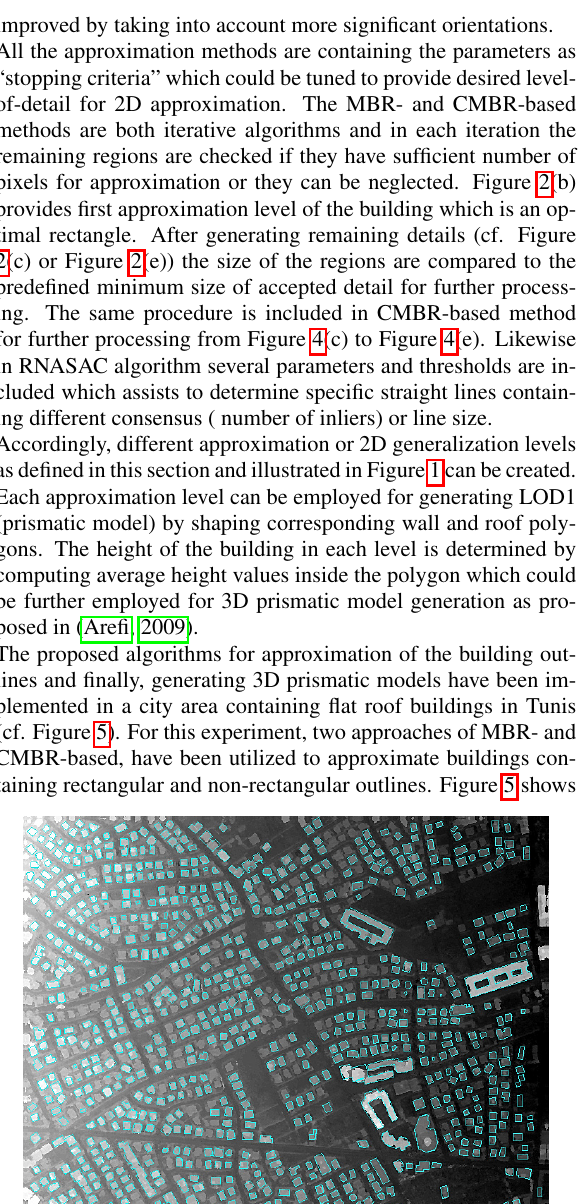
Figure 5: Building outline approximation (green